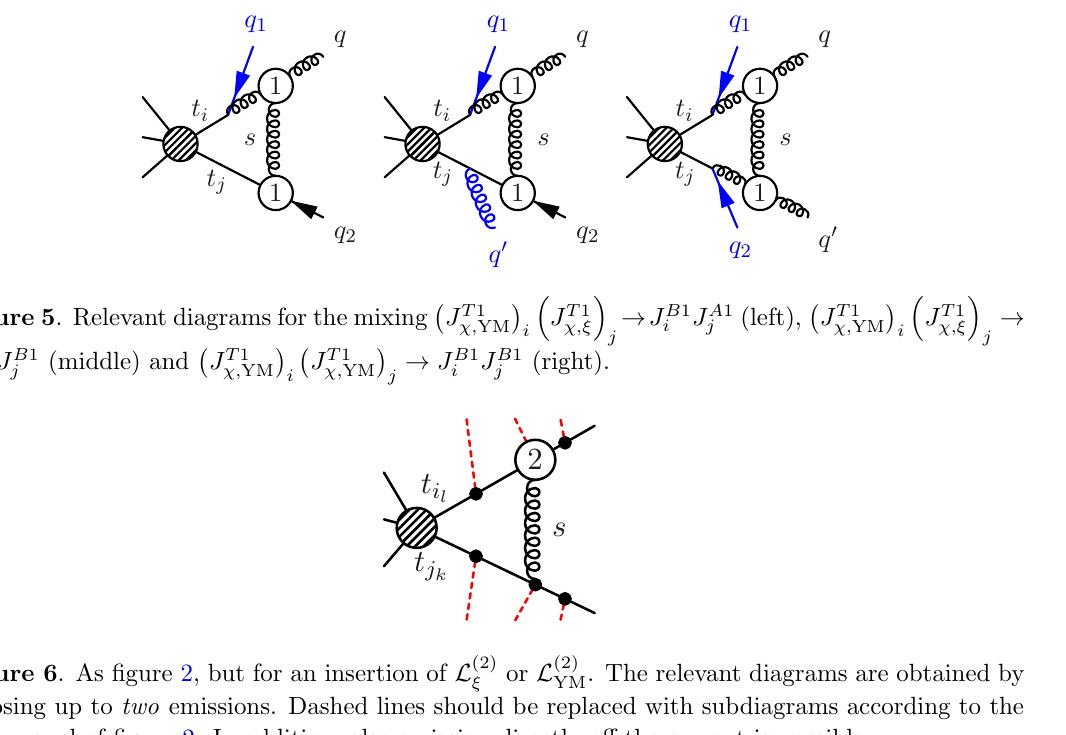
(cid:0) J T 1 (cid:31); YM